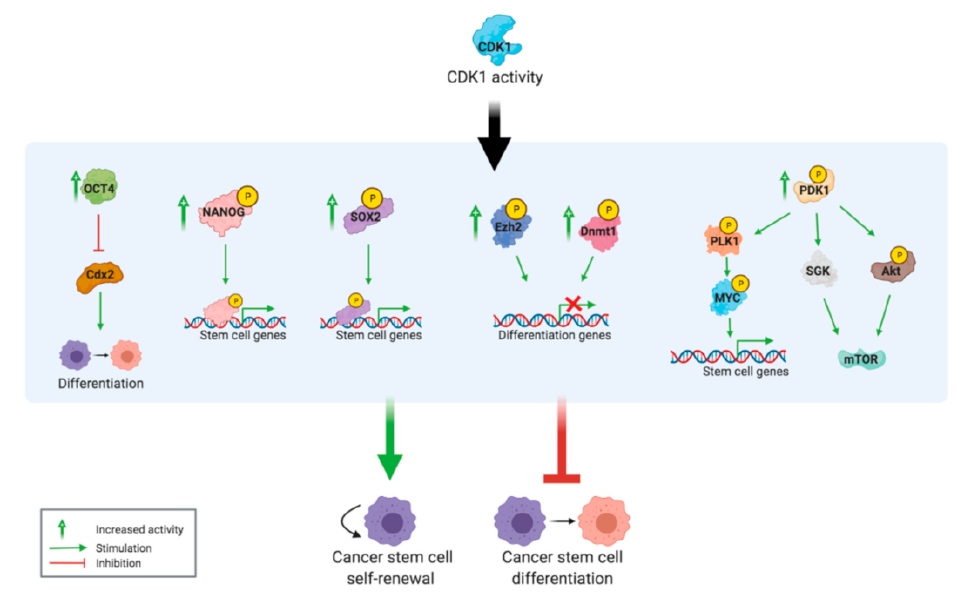
Figure 4. CDK1 overexpression induces cancer stem cell properties. The different mechanisms through which CDK1 overexpression contributes to the formation and maintenance of